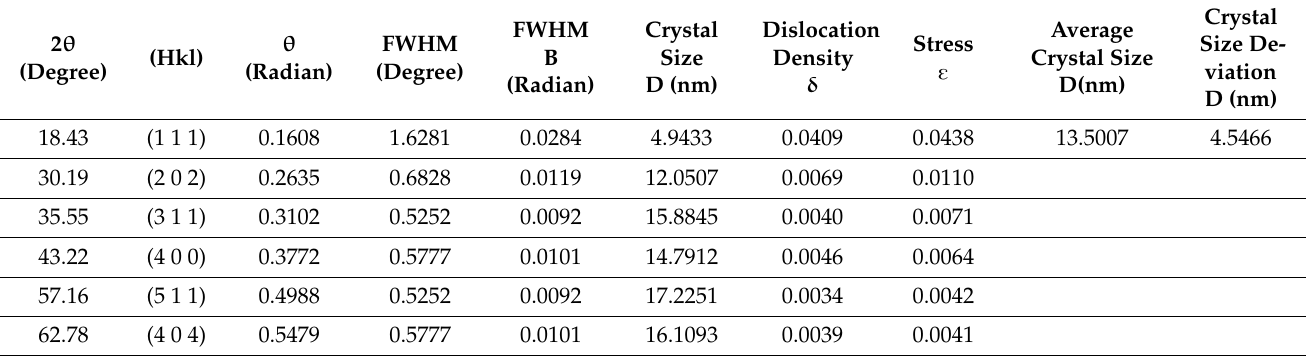
Table 5. Calculated crystallographic parameters of modified Fe 3 O 4 NPs with data obtained from XRD analysis using the Scherrer